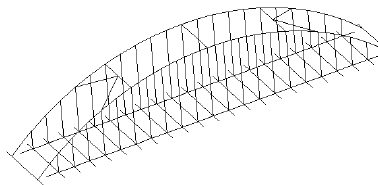
Figure 10. ANSYS/LS ‐ DYNA model of the through CFST standard arch bridge with a main span of 125 m.